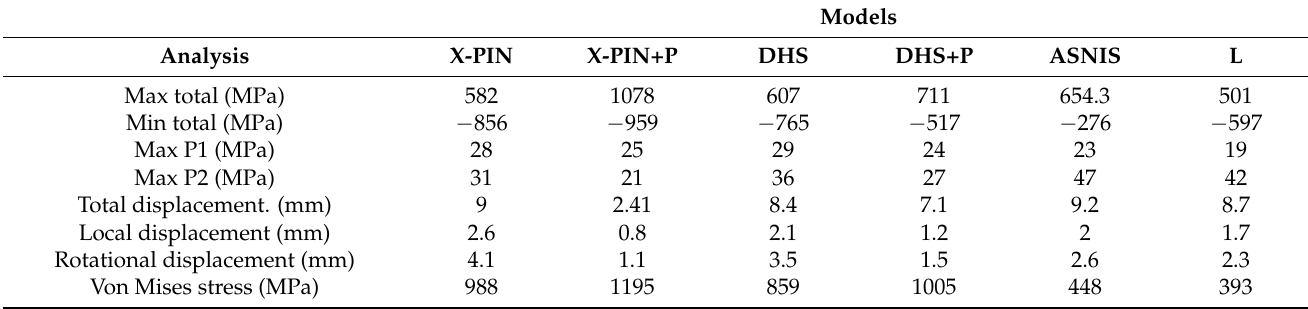
(Figure 7), with the X-PIN+P results 85% and 247% higher than DHS+P and ASNIS,